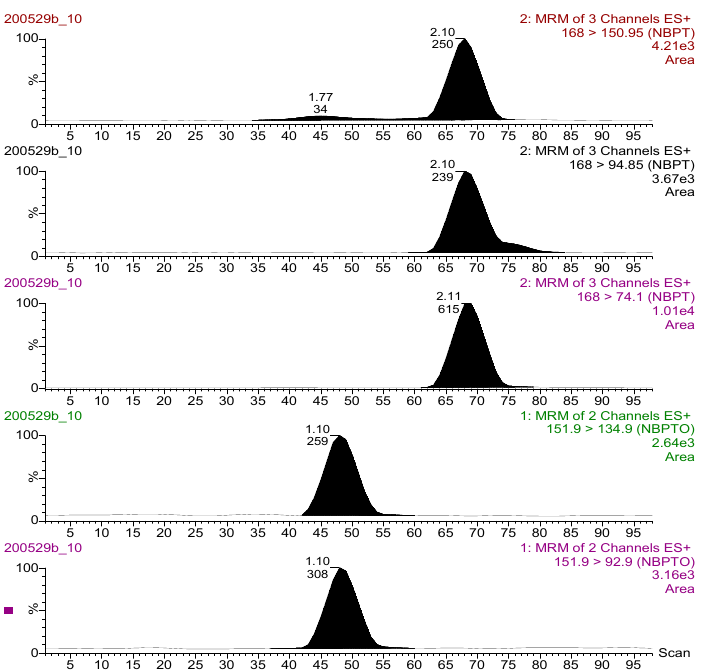
Figure 2. Chromatograms for the transition ions monitored for NBPT (upper three: 168 > 150.95; 168 > 94.85; 168 > 74.10 m / z ) and NBPTo (lower two: 151.90 >134.90; 151.90 > 92.90 m / z ) residues (standard solution 500 ng mL − 1 ) analysed in LC ‐ MS/MS ESI + mode.